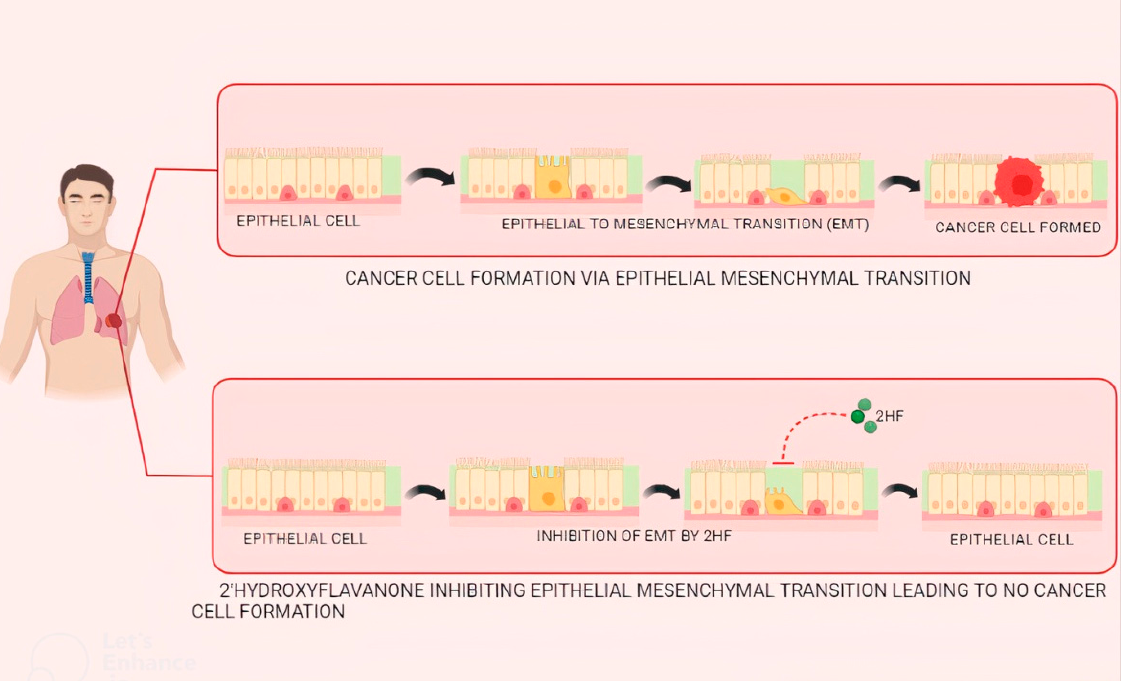
Figure 4. Inhibition of epithelial–mesenchymal transition by 2HF